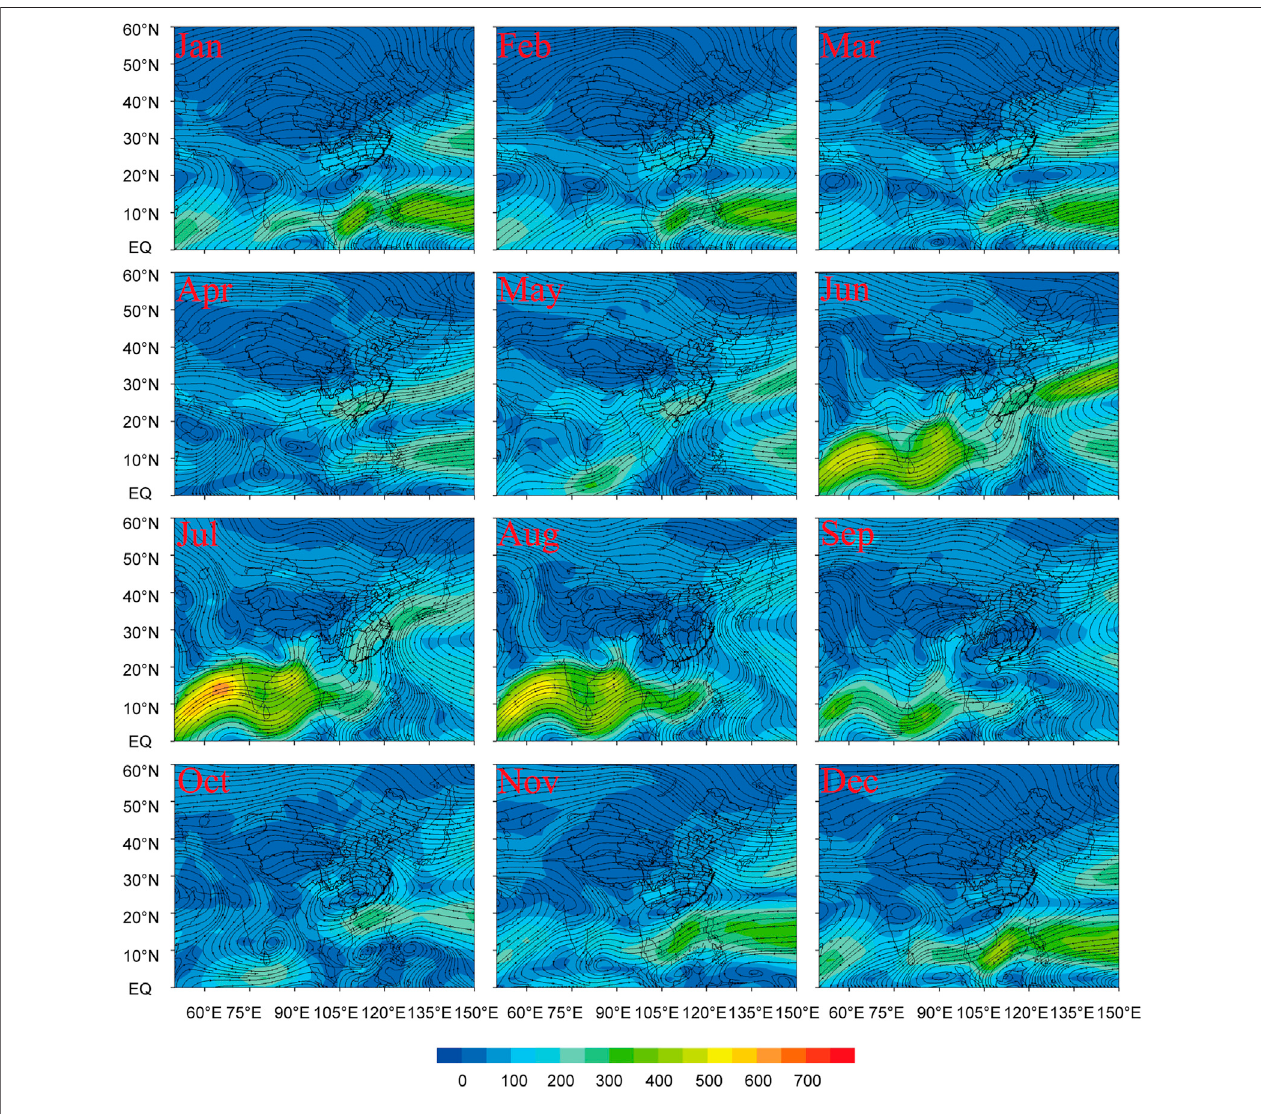
FIGURE 2 | The monthly average vapor fl ux (Unit: gcm − 1 · hPa − 1 · s − 1 ).